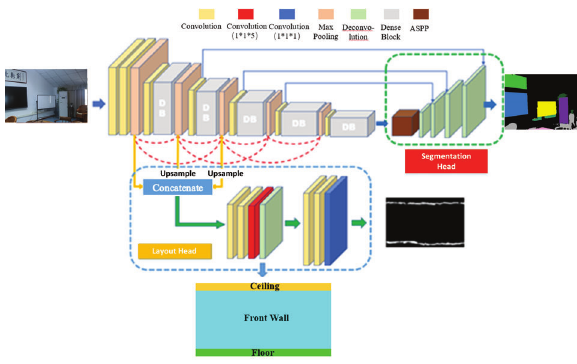
Figure 2. The architecture of